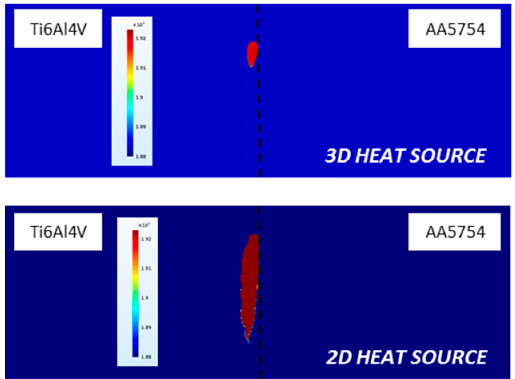
Figure 13. Weld pool numerical results for the numerical simulations.